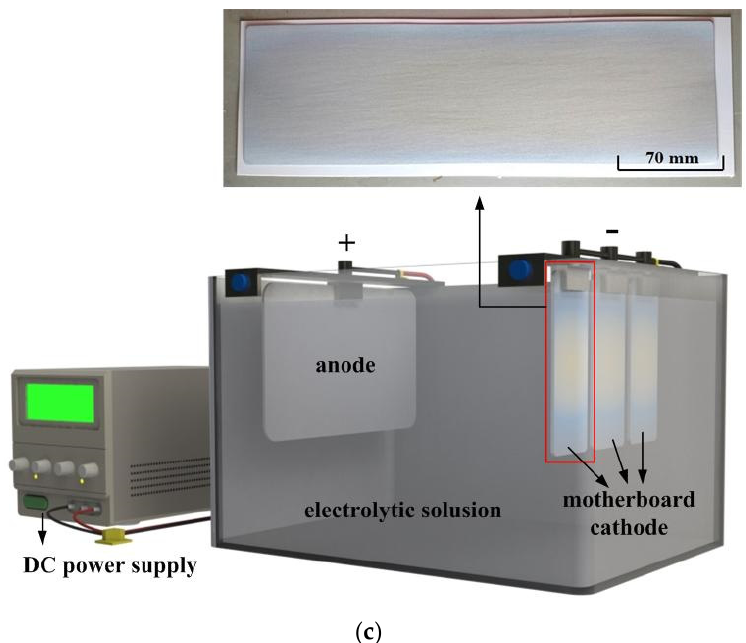
Figure 4. Schematic illustration of electroplated samples ( a ) side view ( b ) top view ( c ) 3D electroplating tank.